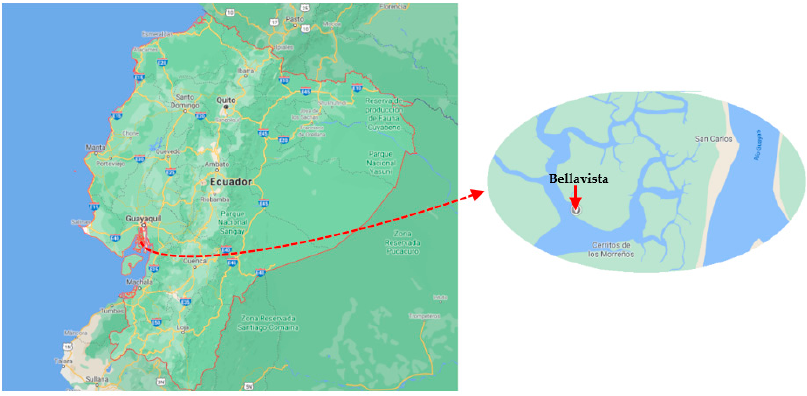
Figure 1. Google Maps view of the Bellavista community highlighting its location.